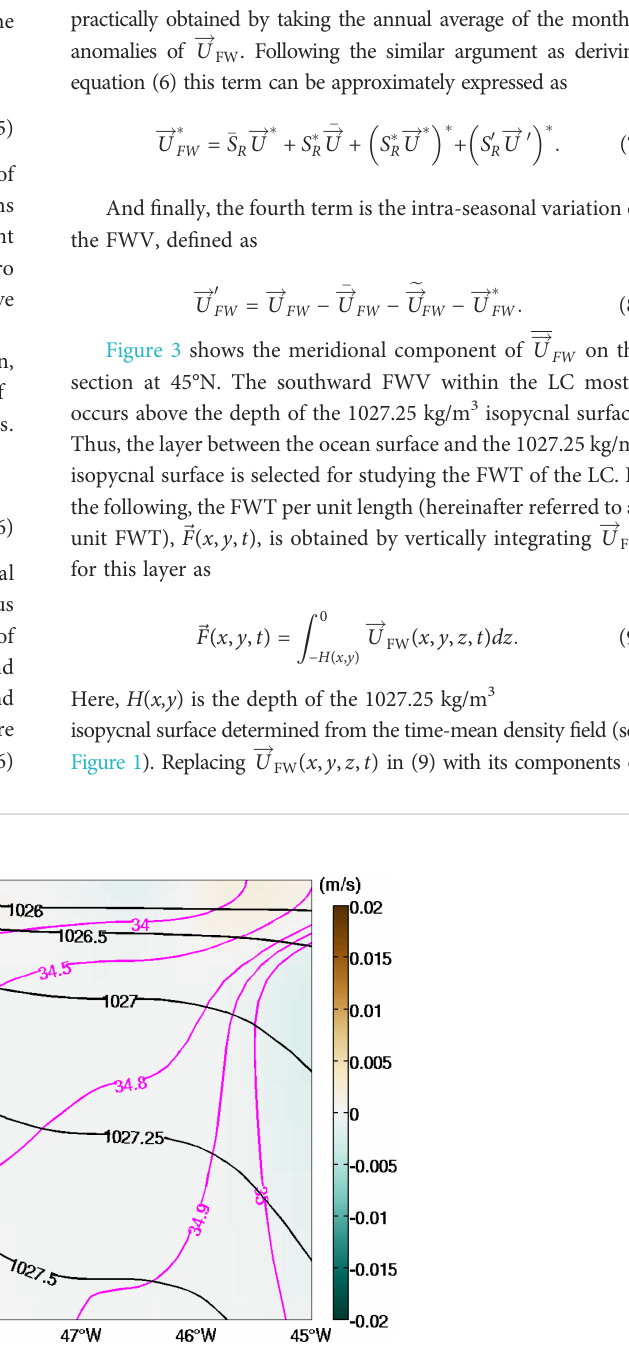
Same as in Figure 2A except that the colors show the meridional component of